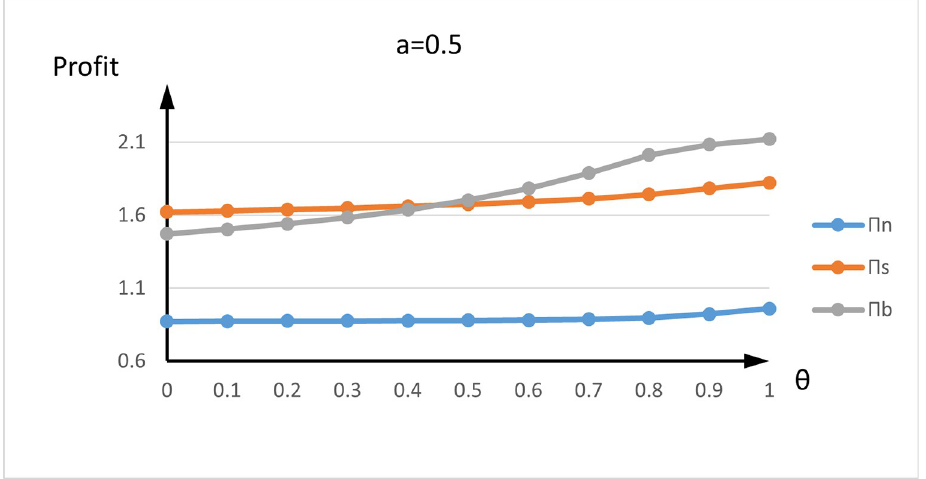
Fig 3. The influence of new high-type customers numbers on the profit of different trade-in strategies.